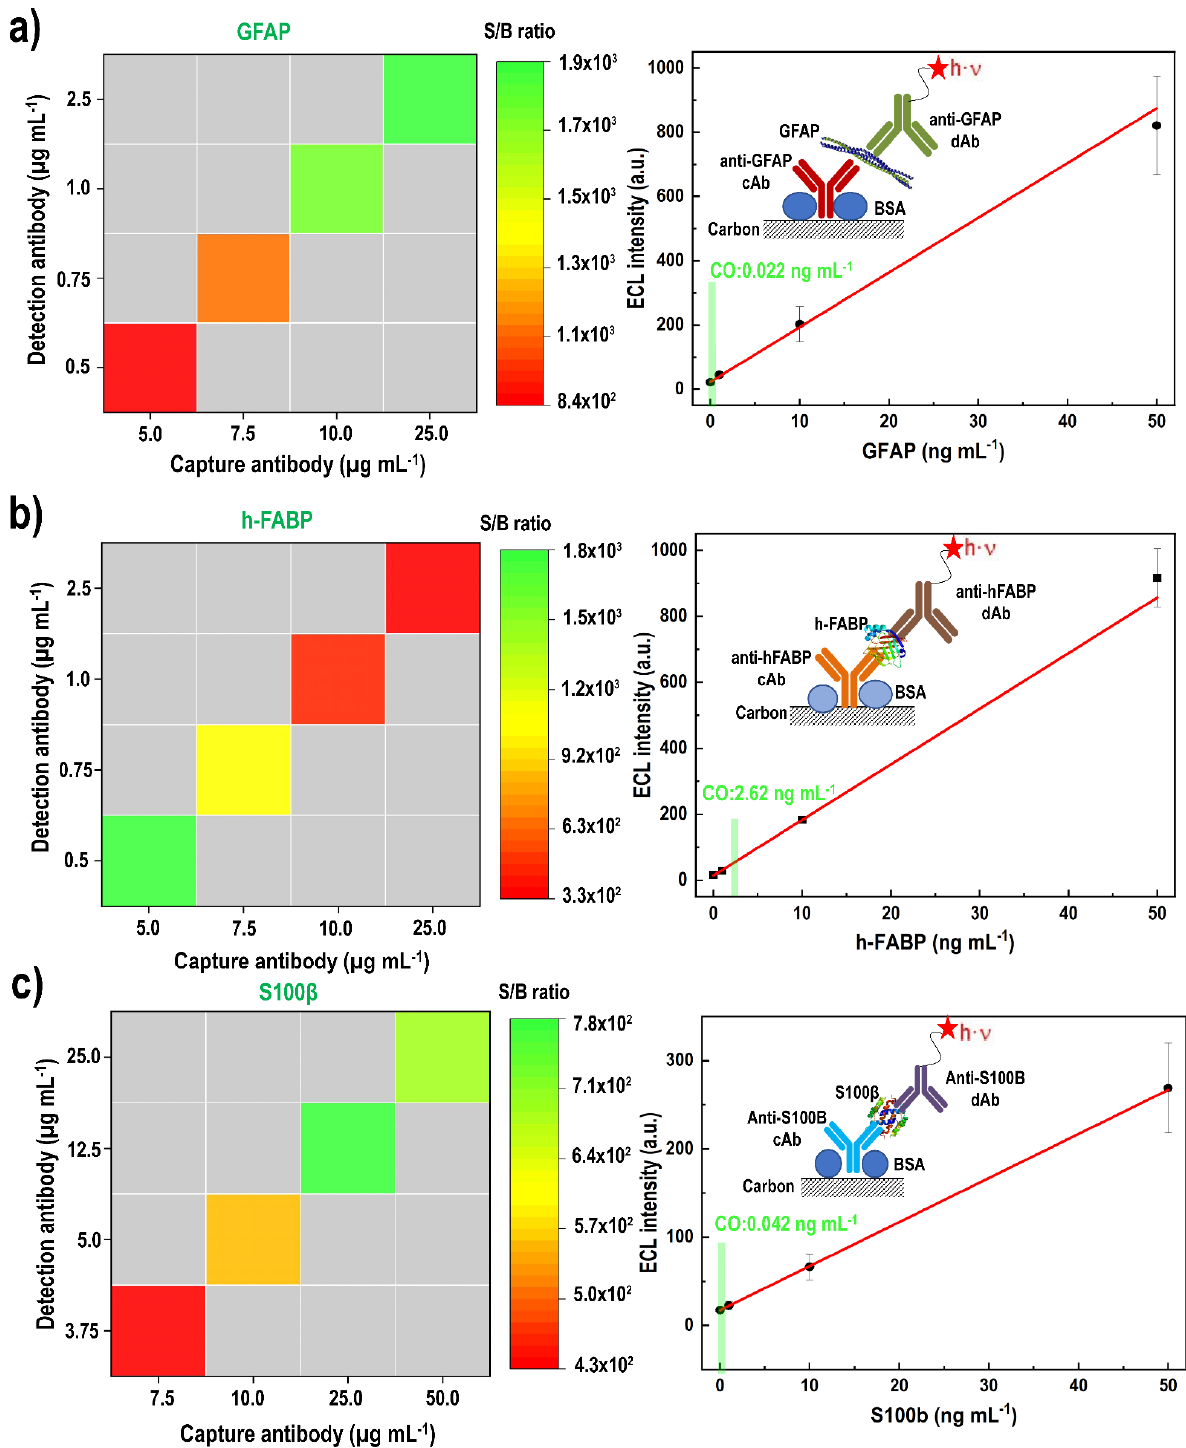
Figure 4. ECL immunoassays for mTBI-relevant biomarkers on SPCE µSTAT-ECL platform: ( a ) GFAP, ( b ) h-FABP, and, ( c ) S100 β . Left figures–Optimization of antibody concentrations in the assay: checkerboard optimization assay for the antibody pairs with the x -axis containing the capture antibody concentrations and the y -axis the detection antibody concentrations (capture/detection antibody ratio 10/1). The results are presented as a heat map plot with reported S/B ratios (100 ng mL − 1 /blank). Right figures—ECL calibration curve established using the conditions listed in Table 4. The error bars represent the standard deviation from three replicates (n = 3); bars are smaller than the data symbol employed.